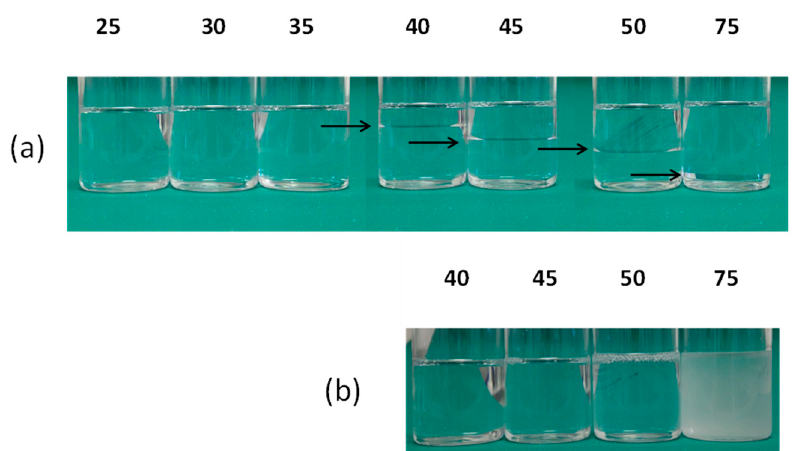
Figure 2. Appearance of the silicone oil/octanol mixtures (1-octanol content indicated in wt%): ( a ) shows the mixtures after a period of standing interfaces following phase separation (where observable) are indicated by the arrows; ( b ) the same mixtures immediately after hand-shaking: cloudiness is obvious for octanol concentrations ≥ 50 wt%.